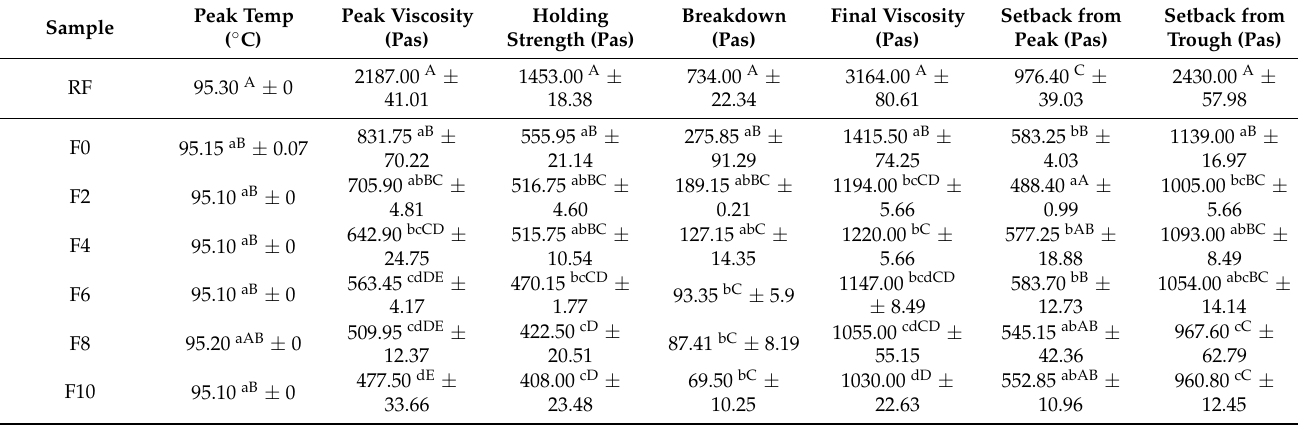
Table 4. Pasting properties of RF, F0, and FRN samples.